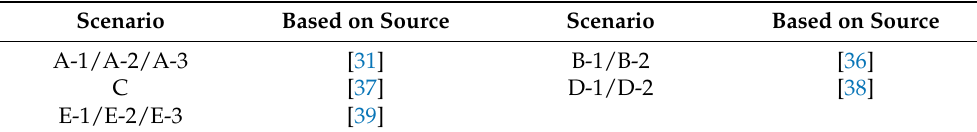
Table 2. Studies used as a basis for the development of heat